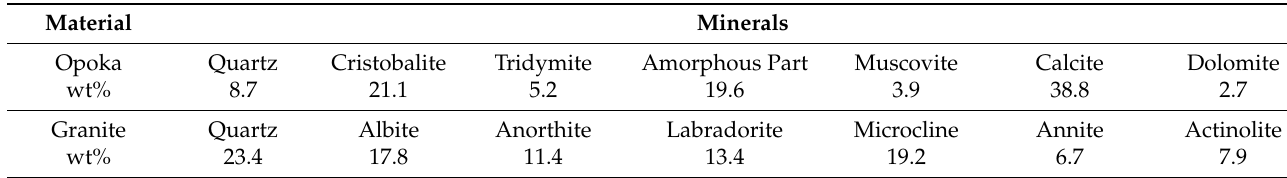
Table 2. Mineral composition of raw